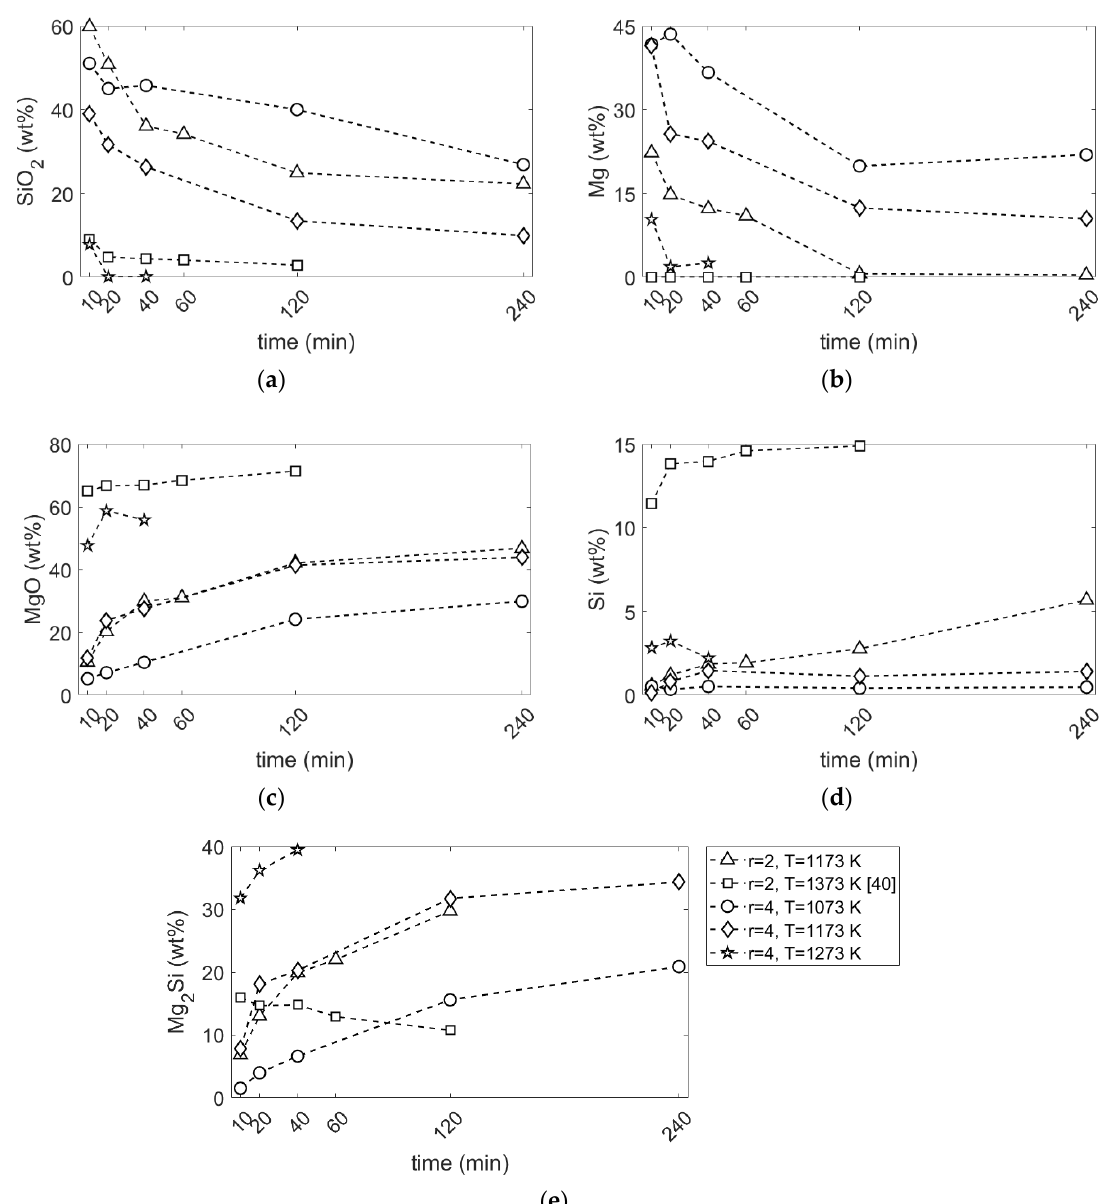
Figure 5. Changes in the amount of different phases against reaction time: ( a ) SiO 2 ; ( b ) Mg; ( c ) MgO; ( d ) Si; ( e ) Mg 2 Si; (r is the Mg/SiO 2 mole ratio). At a Mg/SiO 2 mole ratio of 2, where Mg and SiO 2 react according to Equation (1) to produce MgO and Si, only a small amount of Si was formed: 6 wt% at 1173 K after 240 min, as seen in Figure 5d. The equilibrium amount of Si for complete reduction is 24 wt%. tent is increasing until it reaches approximately to 30 wt% at 120 min reaction time. After